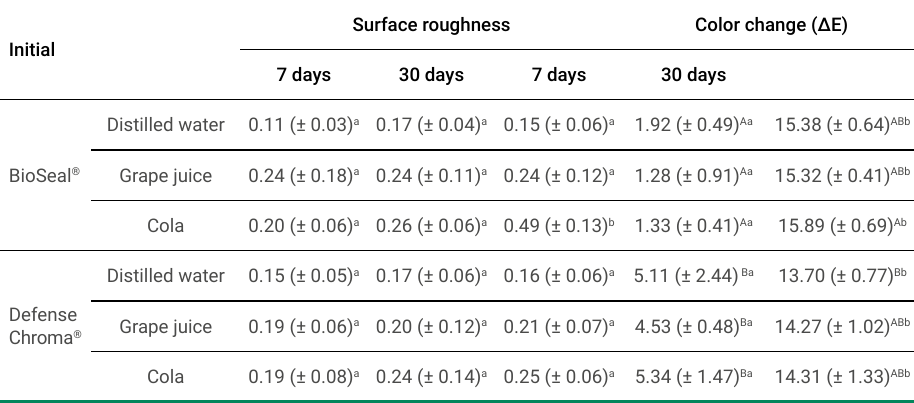
Table 2. Mean and standard deviation of surface roughness (μm) and color change (ΔE) for BioSeal ® and Defense Chroma ® sealants immersed in distilled water, grape juice and Coca-Cola ® for 7 and 30 days.